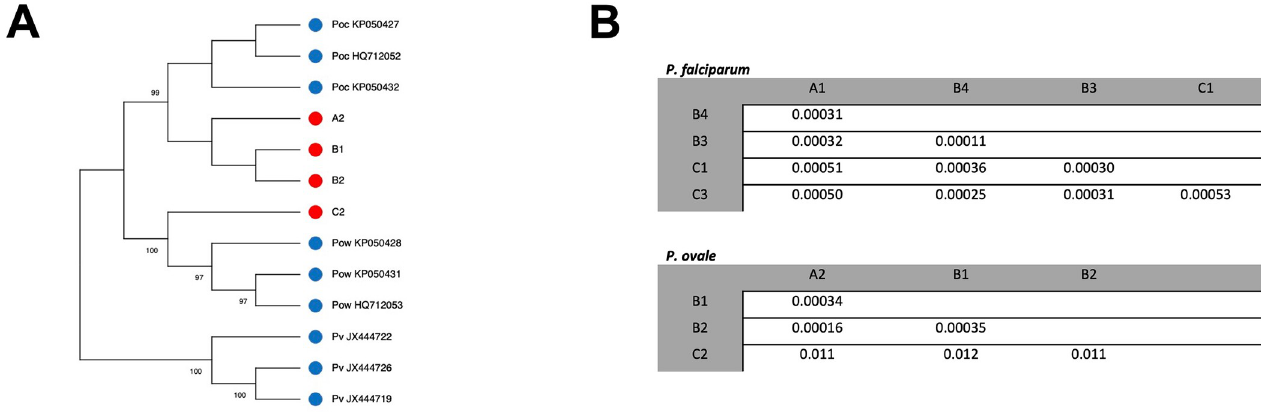
Fig 3. Genetic relationships among the Plasmodium parasites analyzed by RNA-seq. (A) Neighbor-joining tree showing the relationships among cytochrome B sequences from the P . ovale parasites studied in this study (red) and sequences from NCBI (blue). Note that the sequences from the A2, B1 and B2 infections cluster with P . ovale curtisi sequences while the sequence from infection C2 clusters with P . ovale wallikeri sequences. The number next to each branch indicates the percentage of replicate trees in which the sequences clustered together based on 500 bootstraps. (B) Proportion of pairwise nucleotide differences between pairs of P . falciparum (top) and P . ovale (bottom) infections based on positions covered at > 20X. Note the higher proportion of pairwise nucleotide differences in pairs including the C2 infection, consistent with its P . ovale wallikeri determination.